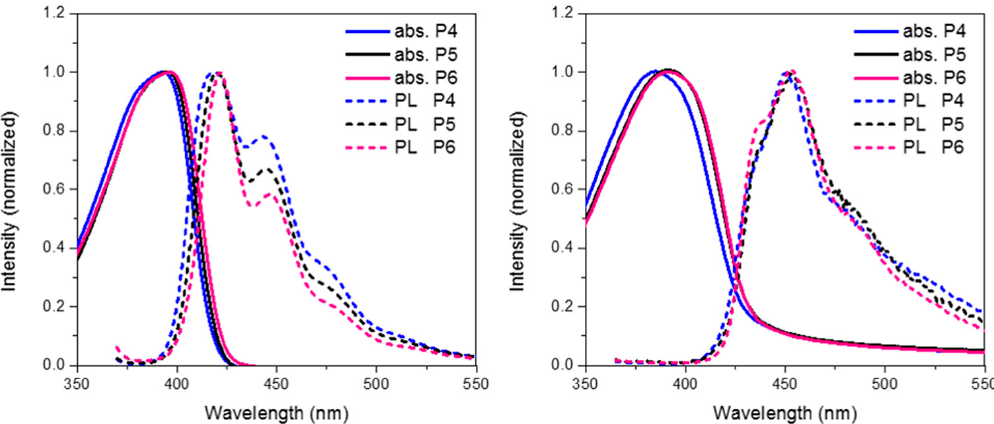
Figure 8. Thin film absorption, emission and HOMO and LUMO of P5 and P6 .